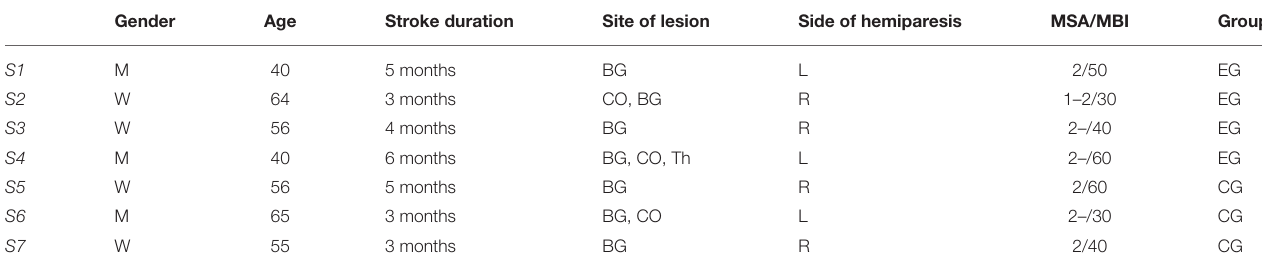
TABLE 1 | Basic information of stroke patients participating in this study. Gender